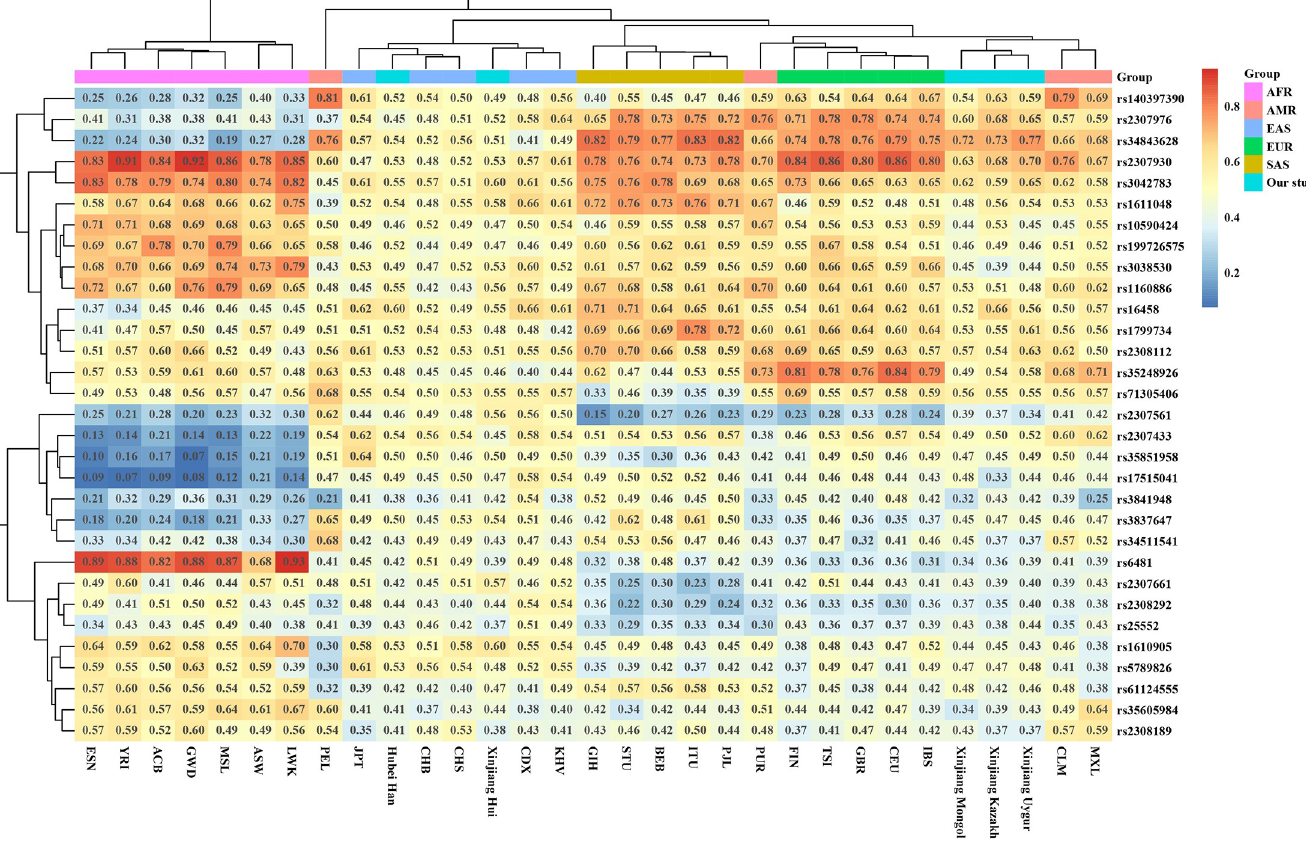
PLOS ONE | https://doi.org/10.1371/journal.pone.0250206 April 22,